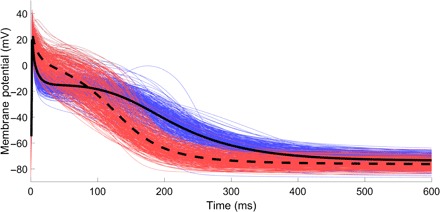
Distributional calibration captures the morphological differences between SR and cAF atrial APs.Atrial APs produced by simulation of the populations of CRN models calibrated to biomarker data for patients exhibiting SR (blue) and cAF (red). In addition, the average of all traces for the SR (solid) and atrial fibrillation (dashed) populations is displayed. The increase in AP triangulation and reduced refractory period associated with cAF is demonstrated, especially by the averaged traces.